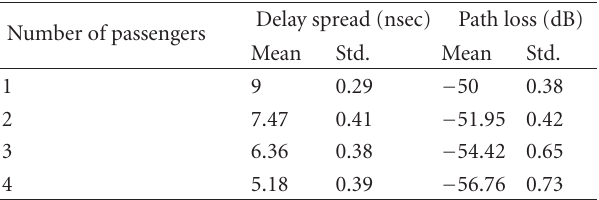
Table 1: Mean values and standard deviations of the rms delay spread and path loss for the global set including the measurements of all the